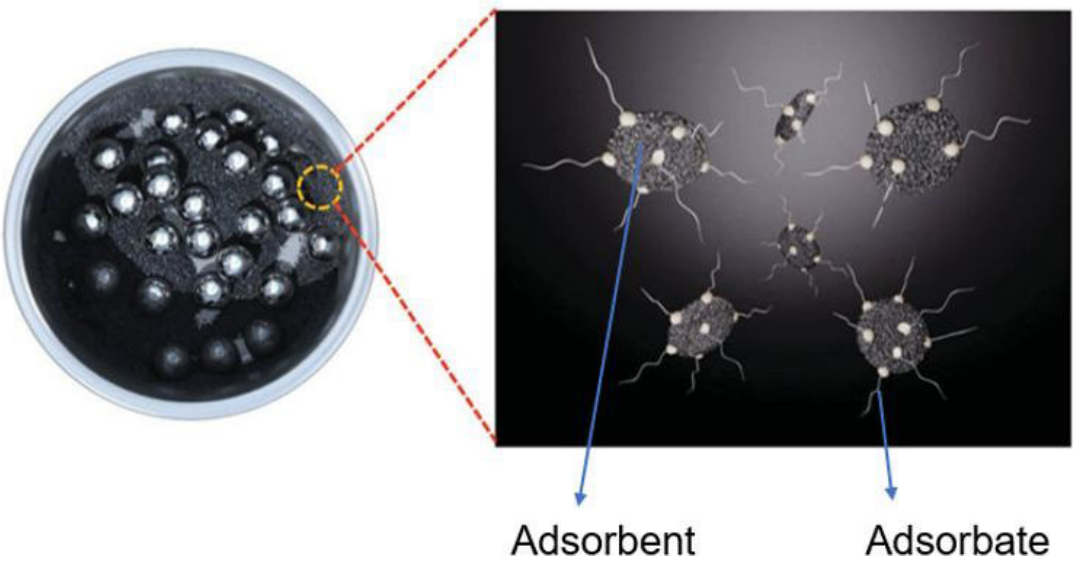
Figure 2. Schematic of PCA in the MA process. Adapted from [ 15 ].